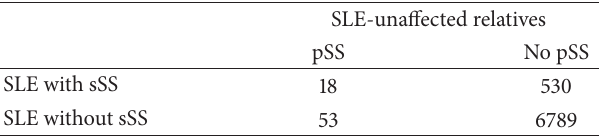
Table 1: Distribution of secondary Sj¨ogren’s syndrome among relatives of those with systemic lupus erythematosus with and without primary Sj¨ogren’s